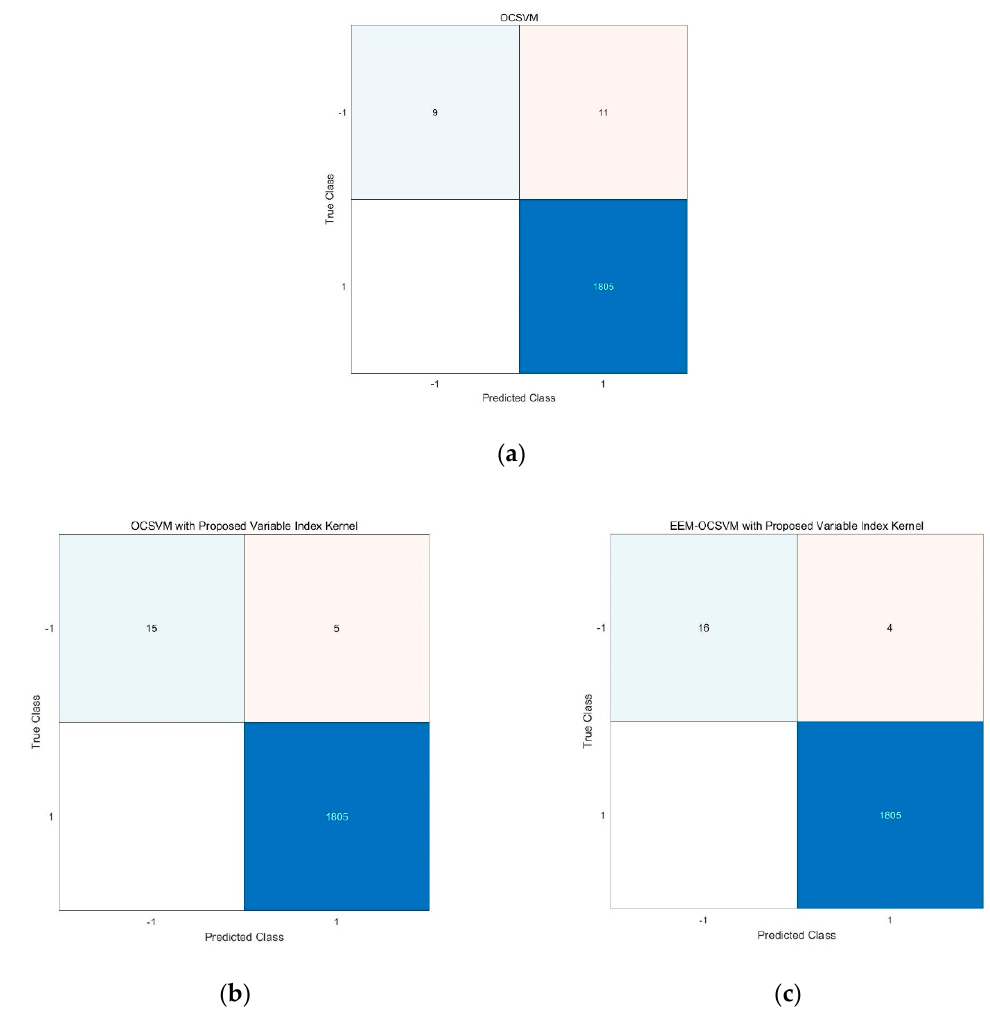
Figure 4. Confusion matrix of each method. ( a ) OCSVM, ( b ) OCSVM with the proposed variable index of the linear kernel function; ( c ) EEM-OCSVM with the proposed variable index of the linear kernel function.